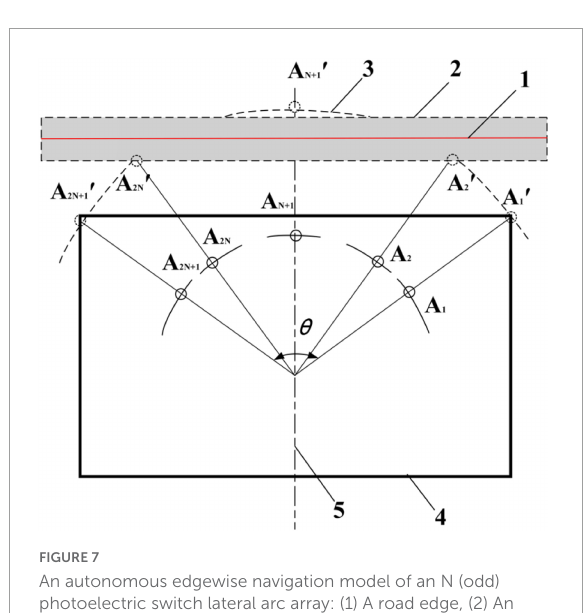
FIGURE8 Calculation and analysis of pose deviation based on a photoelectric switch state.